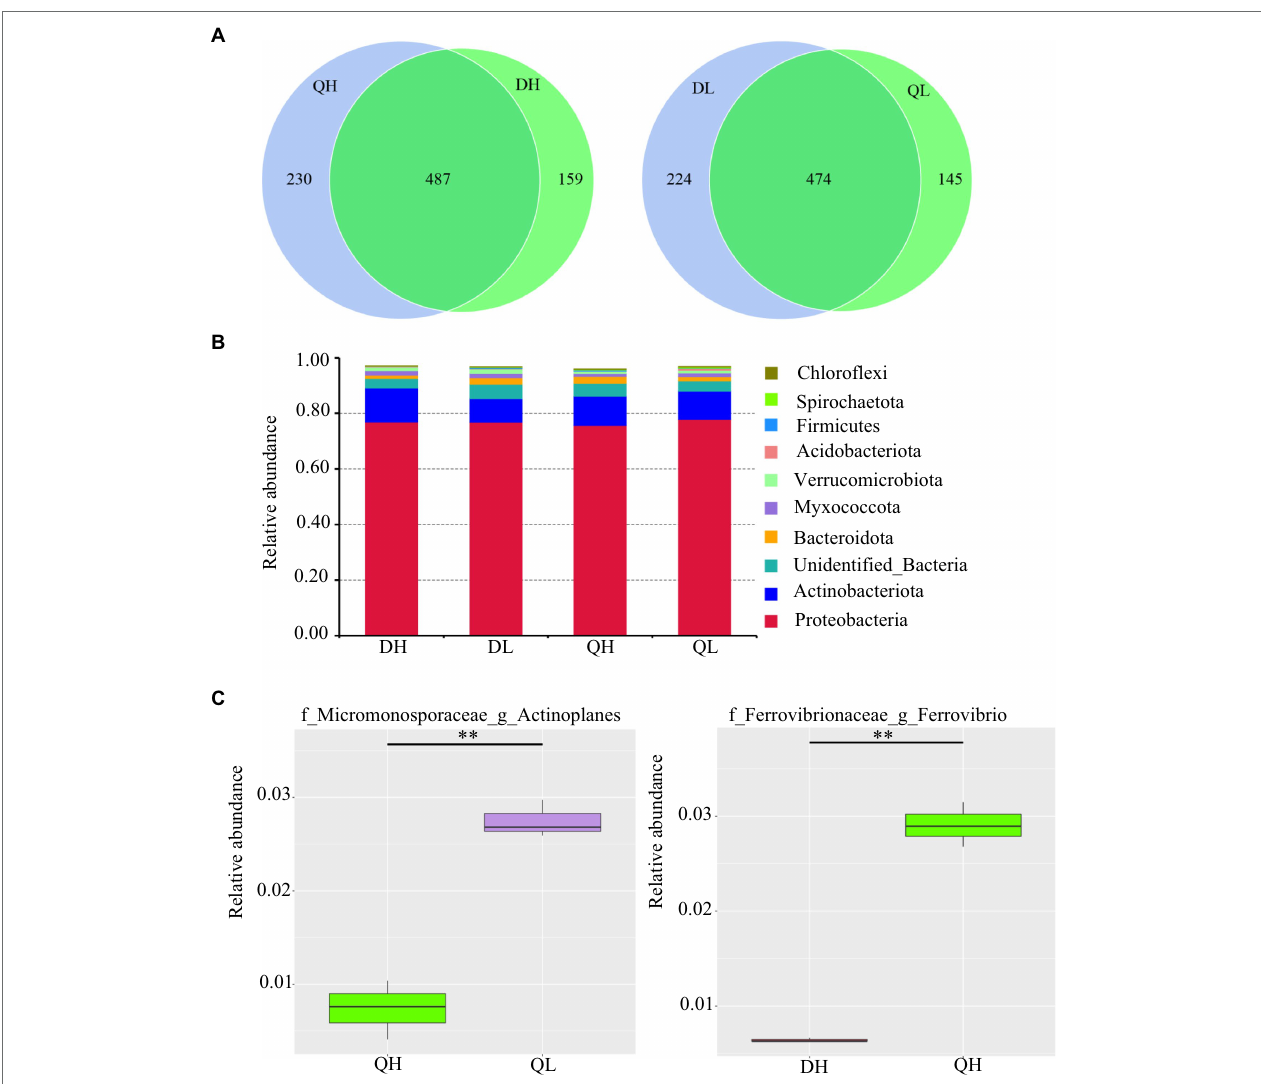
FIGURE 3 | Relative abundance of bacterial taxonomic units in roots of Du Shi and Qing Zhou Mi Tao grown at LP or HP supply. (A) Numbers of differentially enriched bacterial operational taxonomic units (OTUs) in Du Shi and Qing Zhou Mi Tao roots. (B) Relative abundance of bacteria taxa at the phylum level in Du Shi